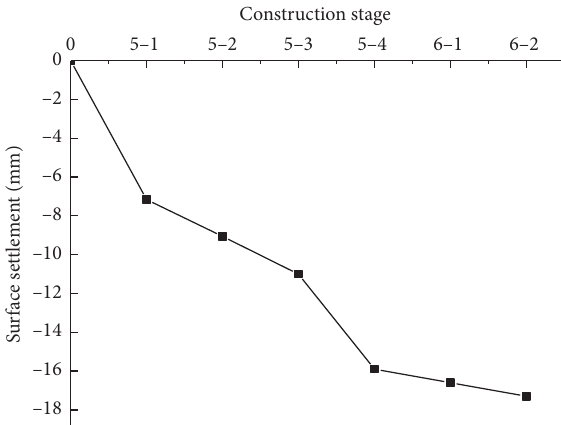
Figure 14: Vertical displacement of measuring point